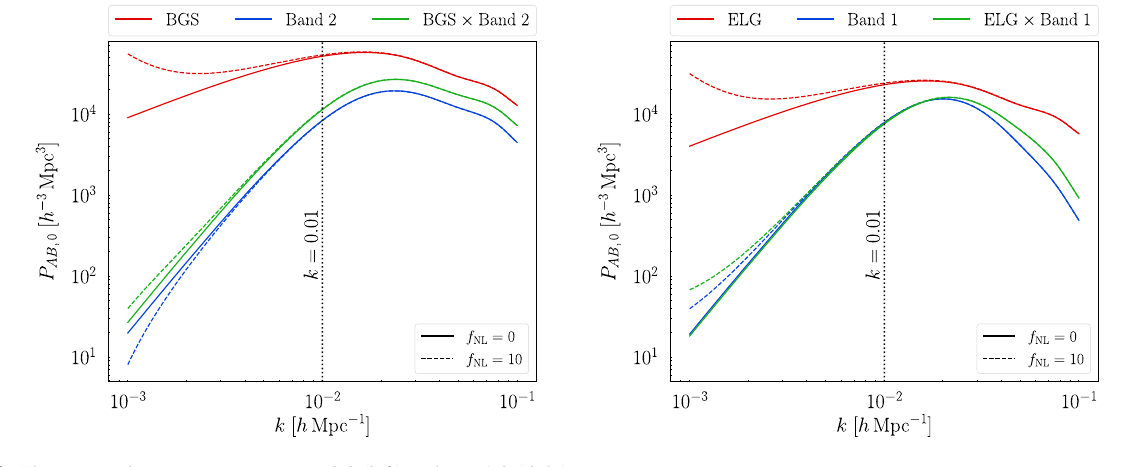
Fig. 3 The monopole power spectra at z = 0 . 3 (left) and z = 1 . 0